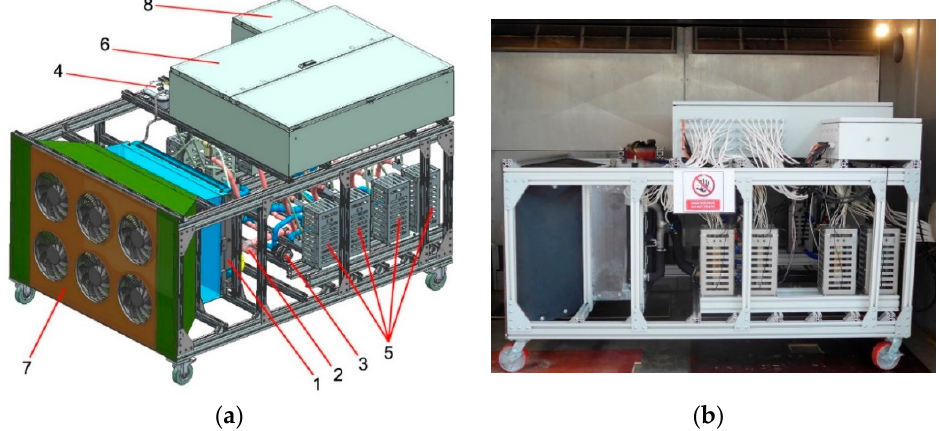
Figure 2. Laboratory test bench for X-in-the-loop (XiL) testing of the thermal management system: CAD model ( a ) and its hardware implementation placed inside a climatic chamber ( b ).